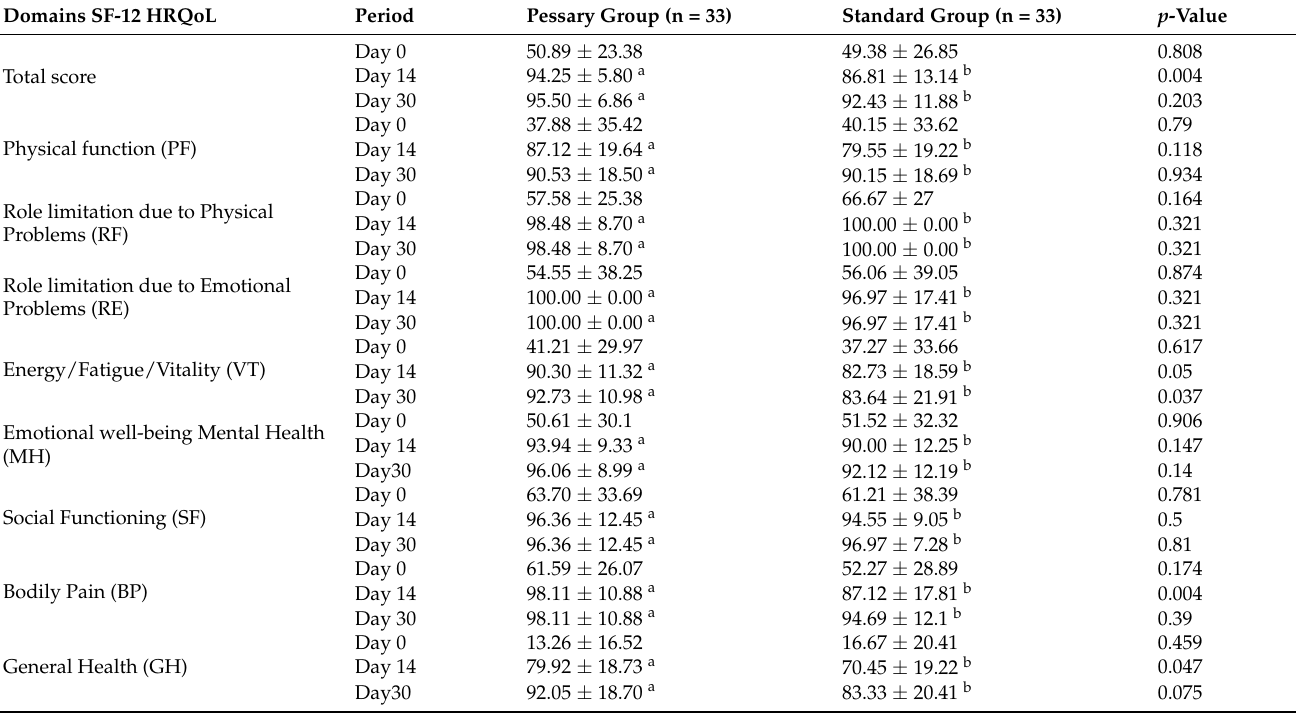
Table 6. The secondary outcome measure based on SF-12 HRQoL.